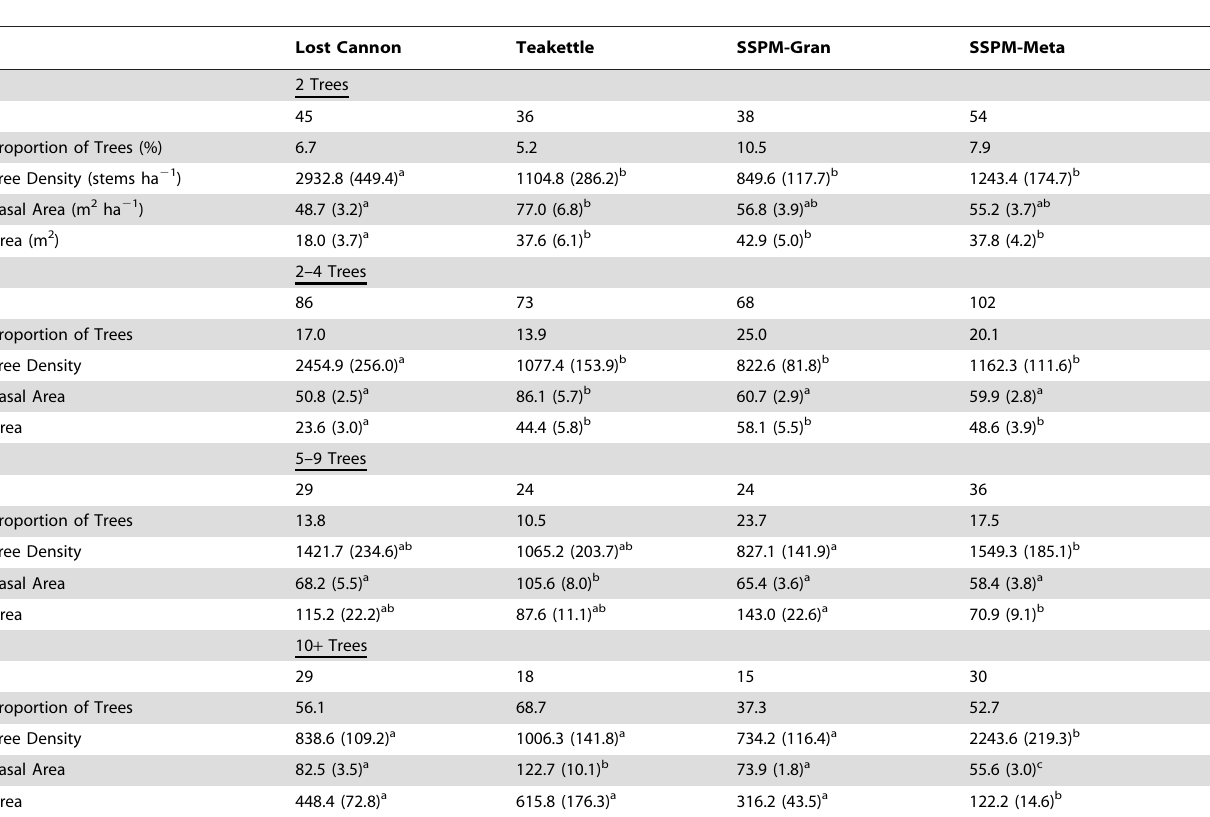
Table 4. Summary of patch attributes in four old-growth Jeffrey pine-mixed conifer forests.